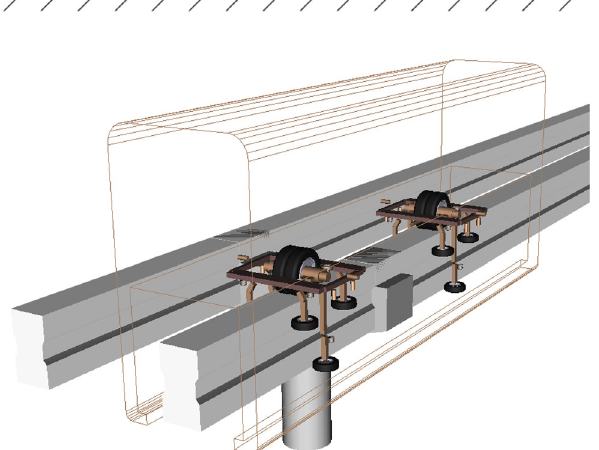
Fig. 8 UM simulation model of vehicle